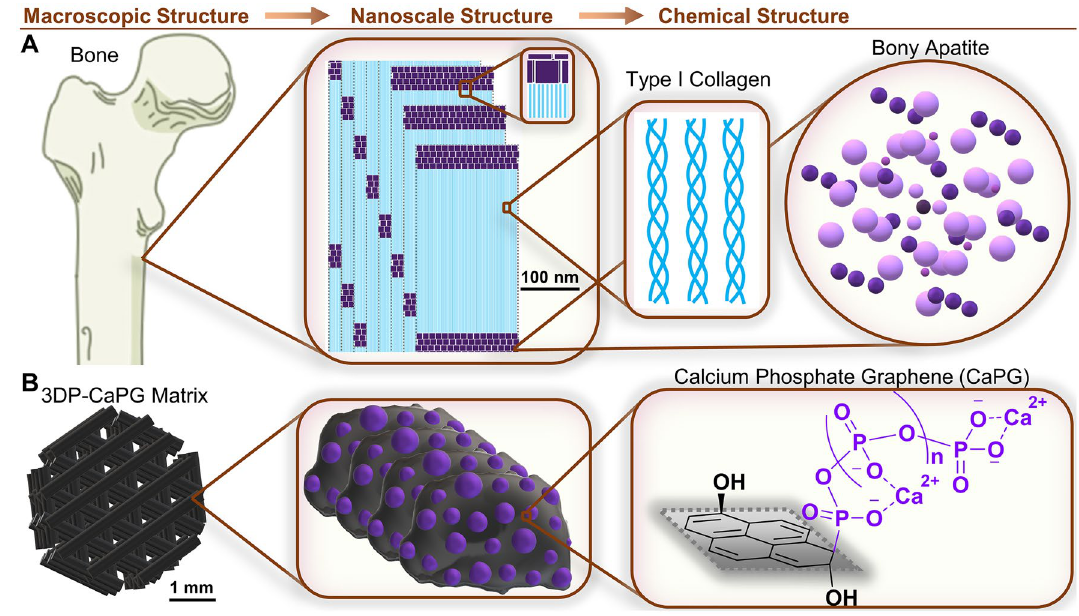
Figure 1. Biomimetic 3D printed CaPG matrix design. ( A ) Illustrative example of the structure of bone at the indicated length scales. ( B ) Illustration of the corresponding 3D printed CaPG matrix structure. Note that the graphenic sheet of CaPG is shown as a pyrene structure for